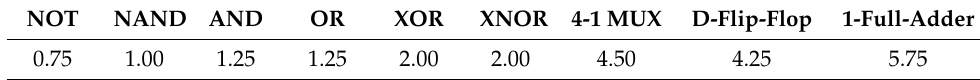
Table 3. Logical component resource